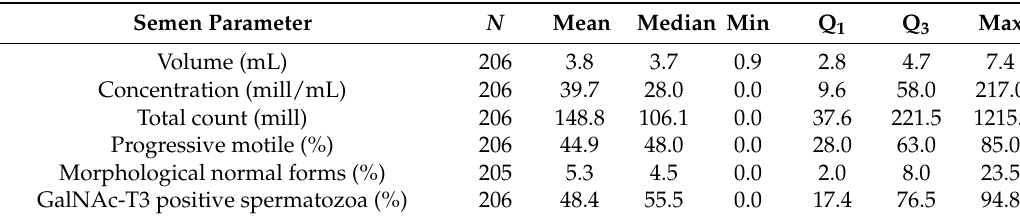
Table 1. Descriptive statistics of the included samples.